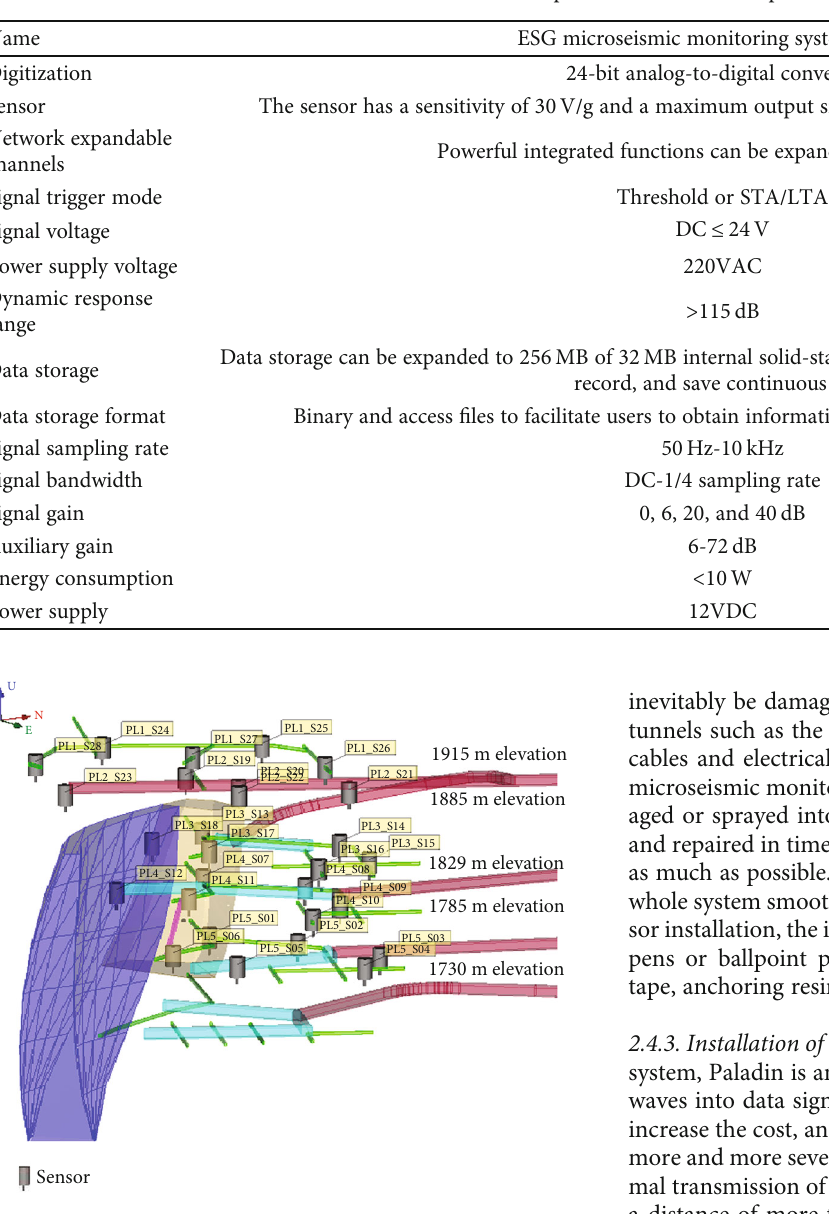
Figure 17: Stability monitoring of left bank slope stability monitoring (sensor space array distribution) in Jinping Primary Diversion Hydropower Station in Yalong